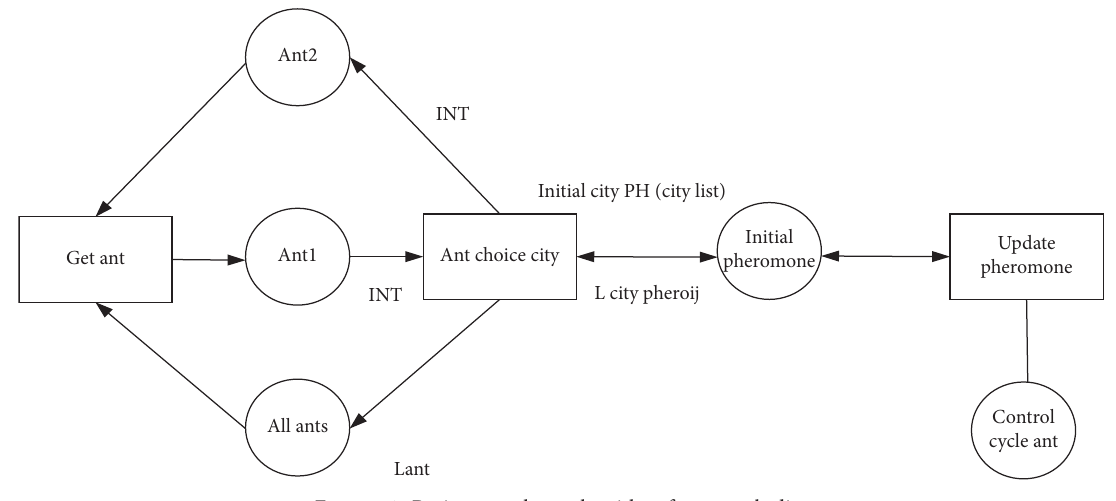
Figure 1: Basic ant colony algorithm framework